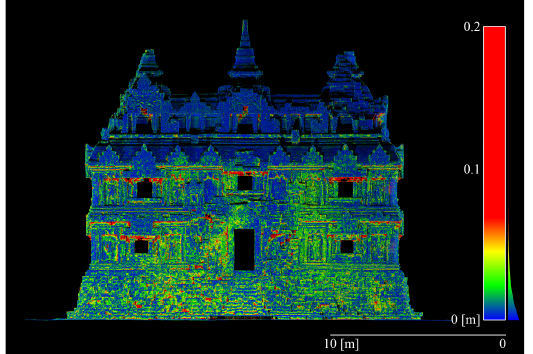
Figure 7. False-color representation of point distances between the laser scanning point cloud and the drone image match data of Candi Sari